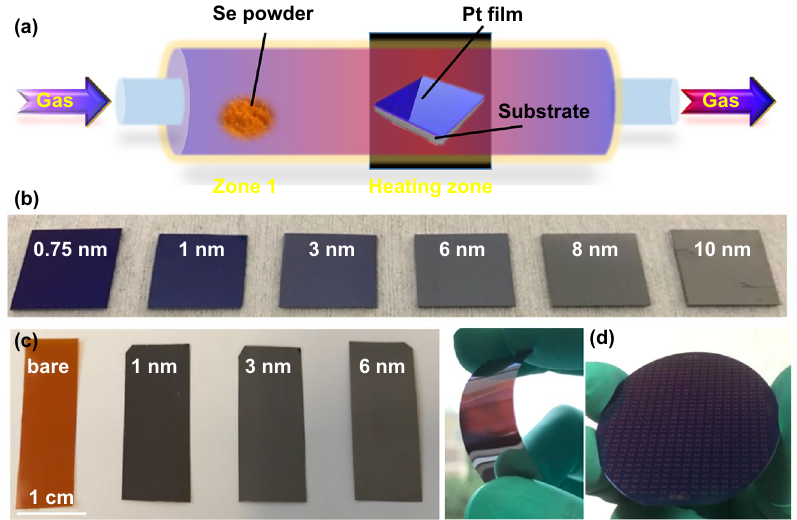
Fig. 8 Large‑scale PtSe 2 film growth by TAC. a Schematic diagram of the CVD system for the synthesis of 2D PtSe 2 film by using TAC pro‑ cess. b Photograph of 2D PtSe 2 film on SiO 2 /Si substrate with controlled thickness. c Photograph of 2D PtSe 2 film on polyimide substrate with controlled thickness. Reproduced with permission [114]. Copyright 2019, American Chemical Society. d Photograph of a wafer‑scale PtS 2 /PtSe 2 film on a 2‑in. SiO 2 /Si substrate. Reproduced with permission [117]. Copyright 2018, American Chemical